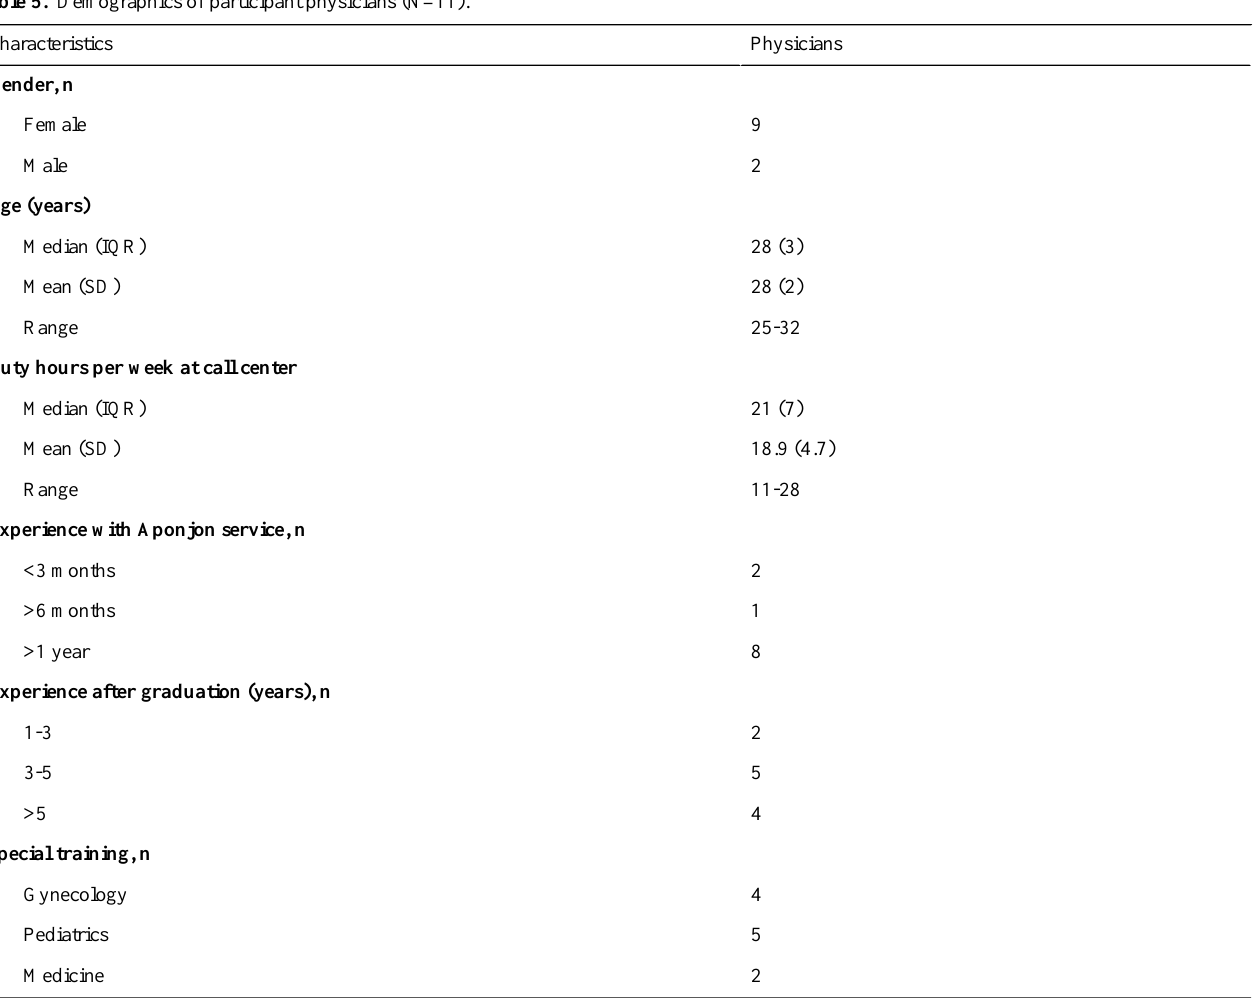
Table 5. Demographics of participant physicians